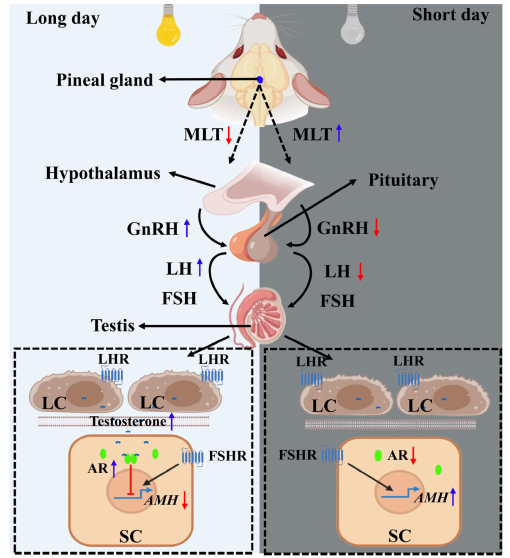
Figure 4. Potential relationship between anti-Müllerian hormone (AMH) and the seasonal reproduction pathway. For long-day breeders, the eyes sense the long day and send signals to reduce the